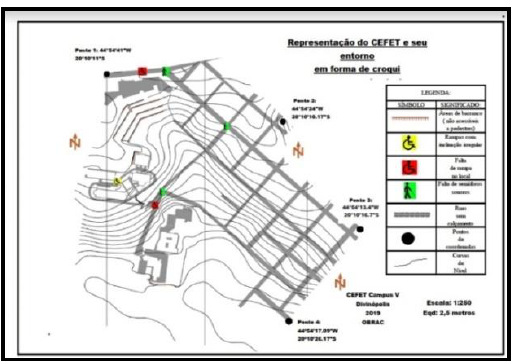
Figure 4. Sketch of the school surroundings - CEFET Team of Divinópolis - MG